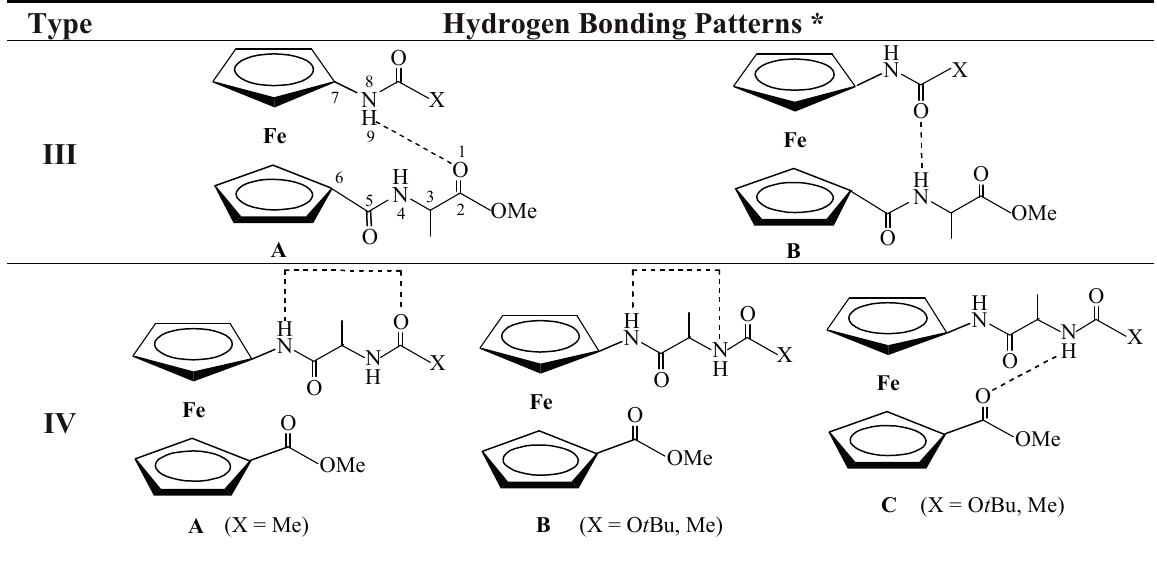
Table 1. Hydrogen bonding patterns of peptides derived from Fca and Ala (the dotted lines represent the hydrogen